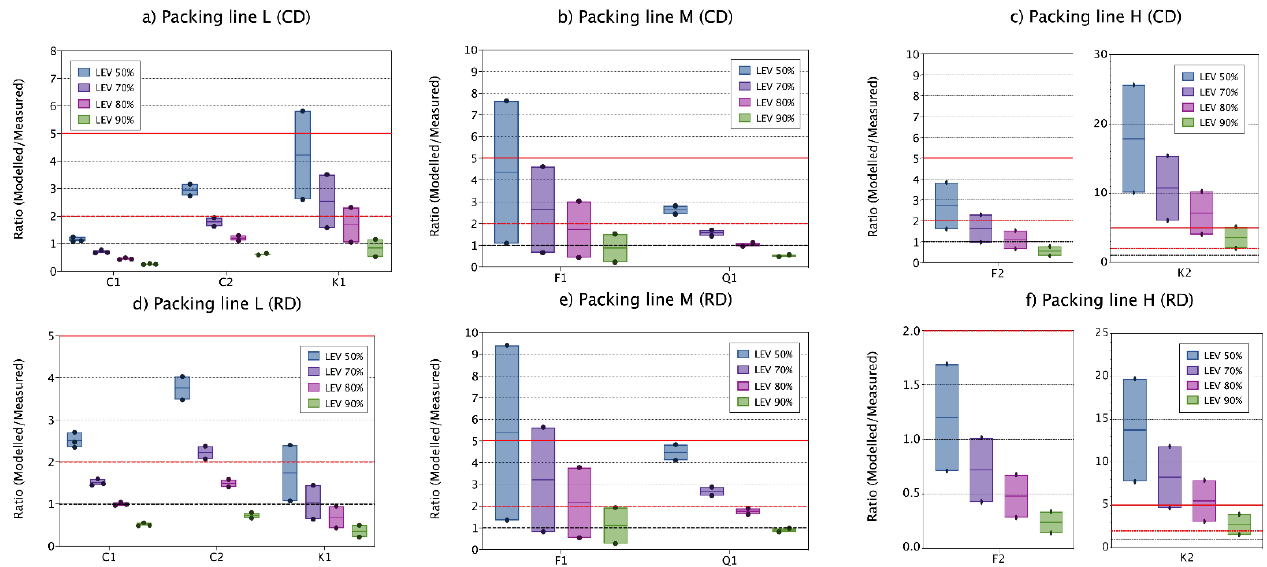
Figure 5. Vertical boxplot for ratio two-box modelled/measured respirable concentrations for all materials when using CD DI ( a – c ) and RD DI ( d – f ) as input parameter for source characterisation. Ratios 1, 2 and 5 are marked as reference (red solid line, red dashed line and black dashed lines, respectively). Solid coloured line within the box indicates the median value, and the limits of the box indicate min and max values. Coloured dots represent the individual replicate values. Modelling parameters: β i fixed at 5 m 3 min −1 .